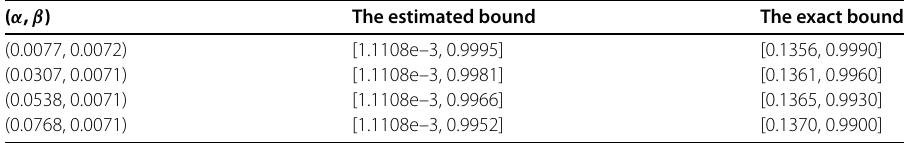
Table 2 Bounds of nonzero real eigenvalues of the preconditioned matrix P –1 Example